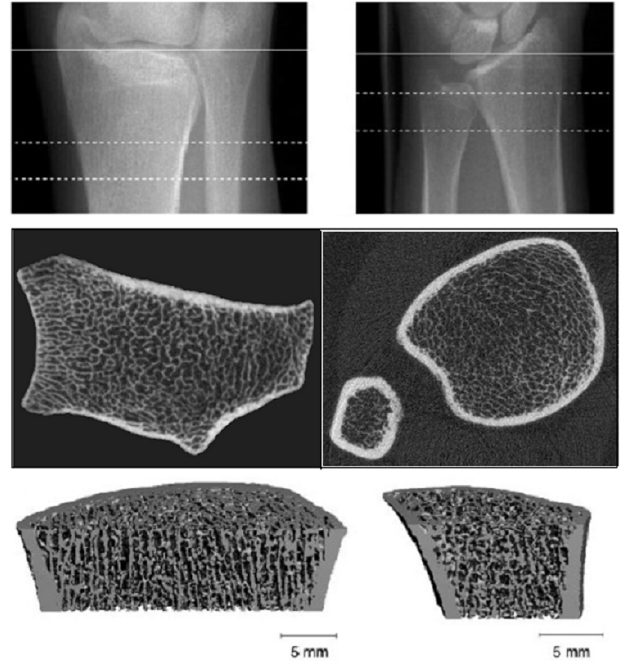
Figure 5. High resolution-peripheral quantitative computerized tomography (HR-pQCT): Analy- sis of trabecular and cortical microarchitecture proximally and distally at ulnar and radial level. Bone loss in CKD is partially due to cortical bone deterioration [42] through augmentation of the cortical porosity and thinning secondary to trabecularization of the endocortical junction [5]. Changes at sites of predominant cortical bone may be a better determinant of the ‘bone disease status’ than trabecular bone-rich sites. In a longitudinal study that included 53 patients with CKD G2 to G5D, CKD patients assessed by HR-pQCT at the distal radius had rapid cortical bone loss during 1.5 years of follow-up, with declines in cortical area, density, and thickness and increases in porosity: − 2.9% (95% CI − 3.7 to − 2.2), − 1.3% (95% CI − 1.6 to − 0.6), − 2.8% (95% CI − 3.6 to − 1.9), and +4.2% (95% CI 2.0 to